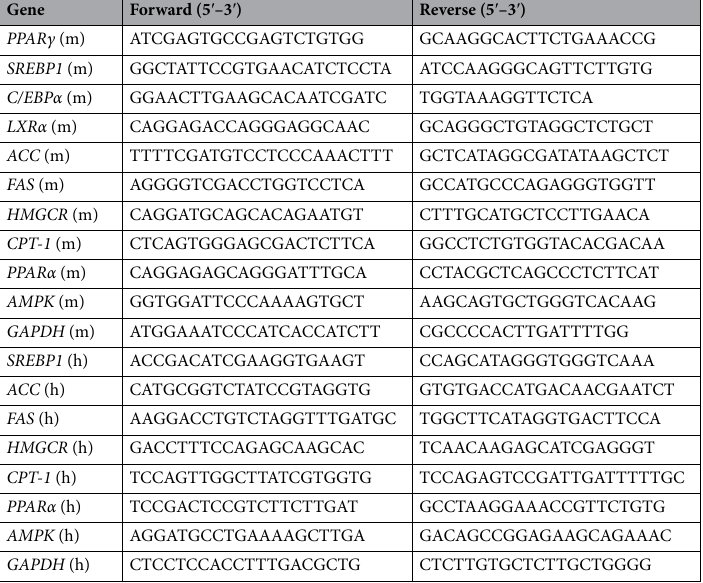
Table 1. Real-time PCR primer